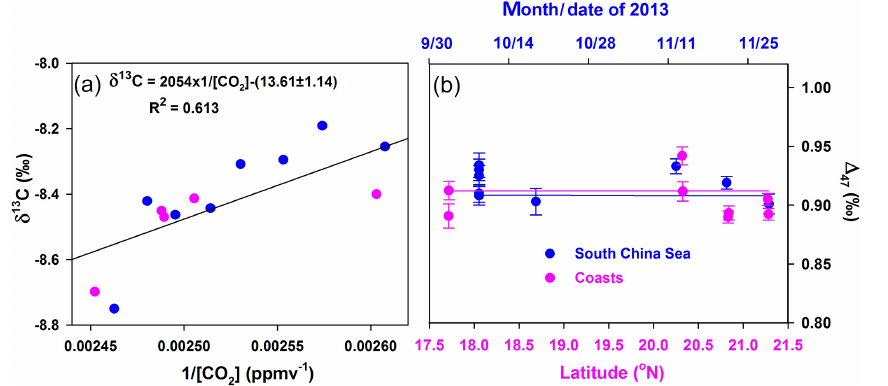
Figure 5. (a) Carbon Keeling plot for air CO 2 collected over South China Sea (blue symbol) and coastal stations (pink symbol) (Keelung and Fugui Cape). (b) (cid:49) 47 values observed over the South China Sea and coastal stations. The error bars are the 1 standard error associated with the measurements. Lines show (cid:49) 47 values for the CO 2 in thermodynamic equilibrium at ambient